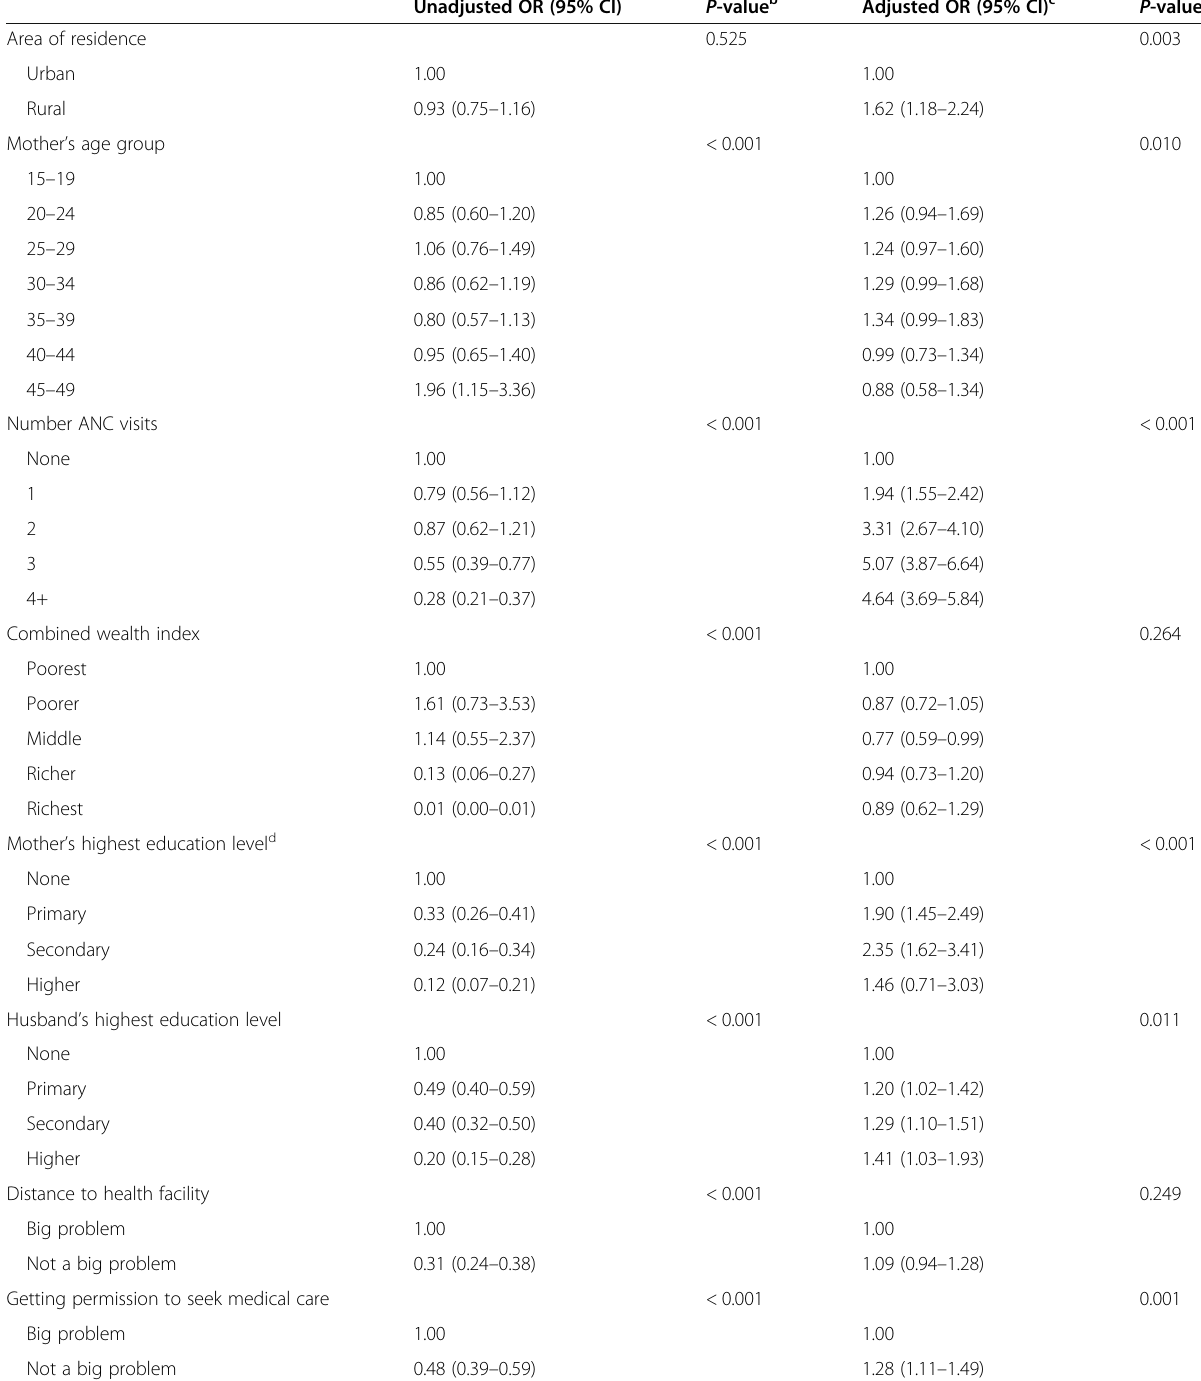
Table 5 Logistic regression model for sufficient antenatal TTCV in women living in rural vs. urban areas, with adjustment